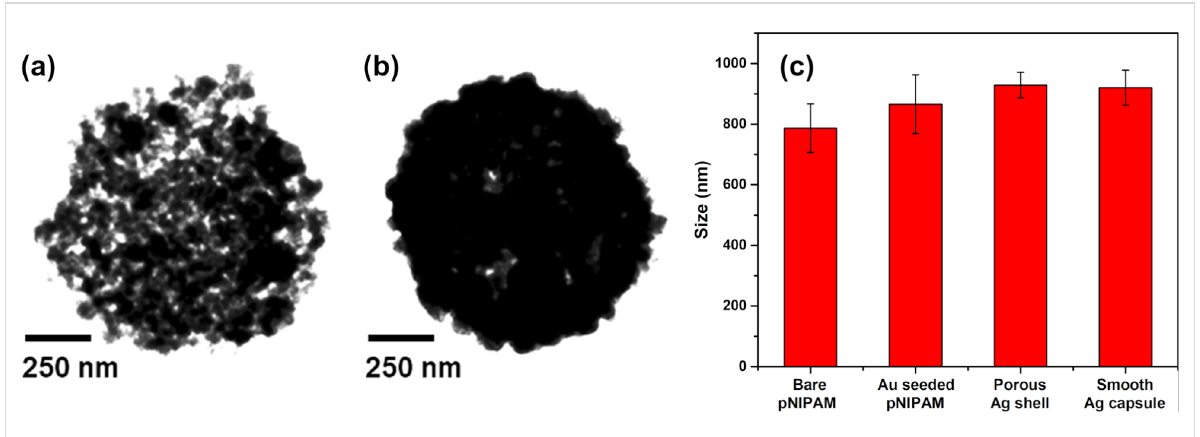
Figure 5: TEM images of (a) porous silver nanocapsules with hydrogel cores ( ≈ 930 nm in diameter), (b) silver nanocapsules with hydrogel cores ( ≈ 920 nm in diameter), and (c) stepwise particle size (diameter) distribution plot.